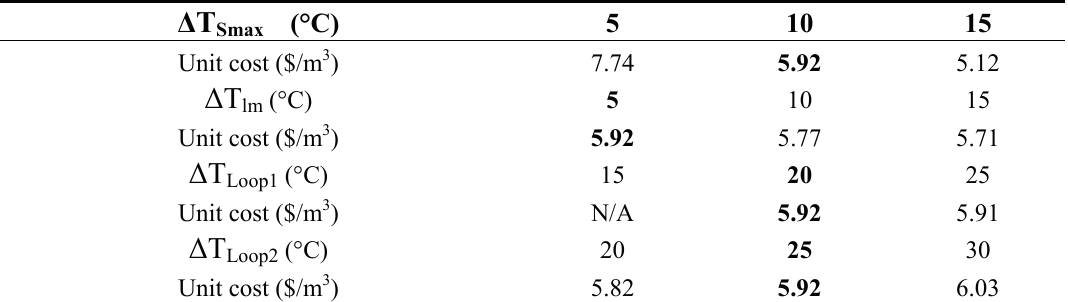
Table 6. Sensitivity analysis of the pseudo-steady-state